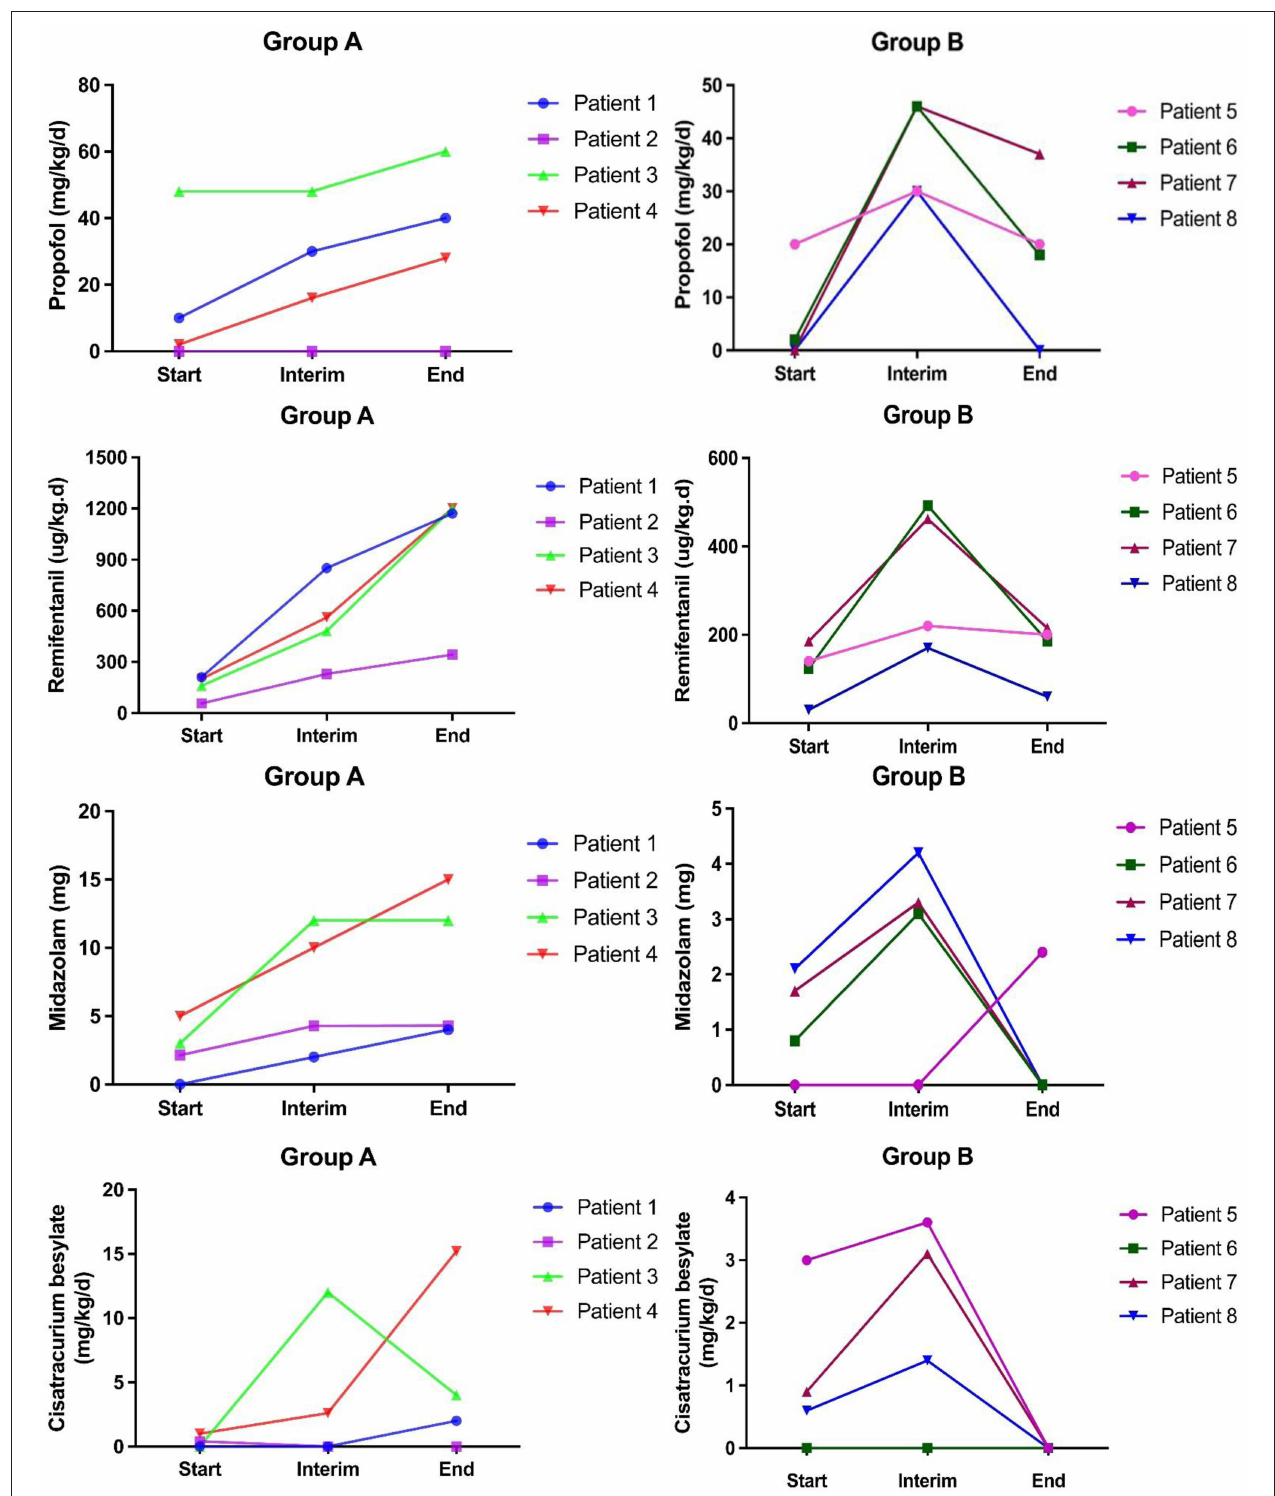
FIGURE 1 | Use of sedative, analgesic and muscle relaxants during ECMO treatment: Group A was the death group, and Group B was the survival group. The usage period was divided into three main time points, namely, the ECMO start date (Start), the ECMO support interim period (Interim), and the ECMO support end date (End). The dose units used for propofol, midazolam, and cisatracurium were mg/kg/d, and those for remifentanil were ug/kg/d.